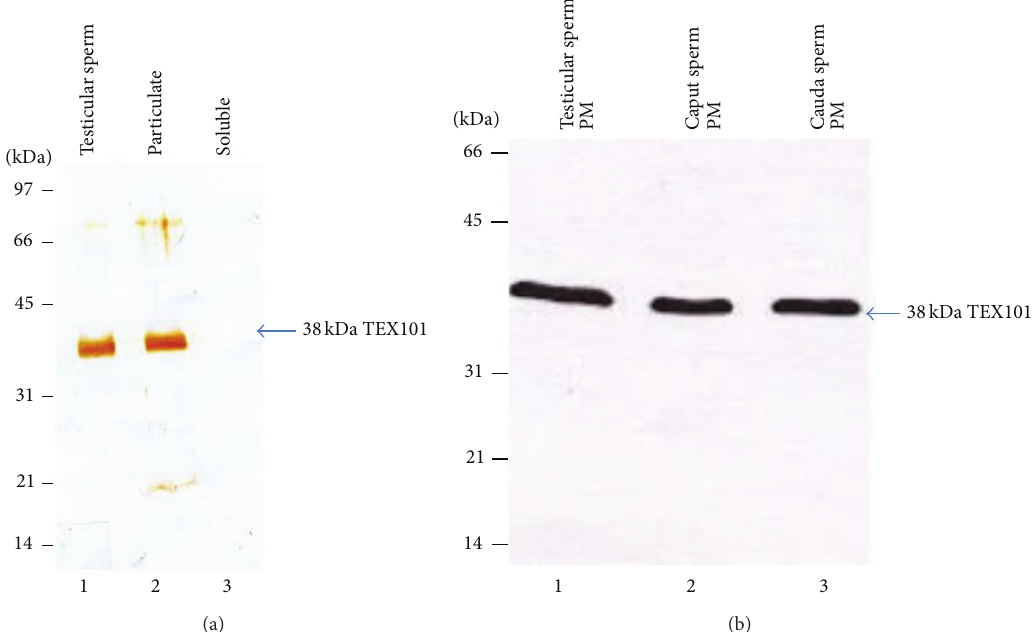
Figure5:(a)WesternblotimmunostainedwithTEX101antibodyshowingtotalbovinetesticularspermlysate(lane1)andtheparticulate(lane 2) and soluble (lane 3) fractions obtained from testicular spermatozoa (2 × 10 6 spermatozoa). TEX101 is only associated with the particulate fraction. (b) Immunoblot of plasma membrane fractions of testicular (lane 1), caput epididymal (lane 2), and cauda epididymal (lane 3) spermatozoa stained with anti-TEX101. Each lane contained 10 𝜇 g protein. TEX101 is present in all three plasma membrane